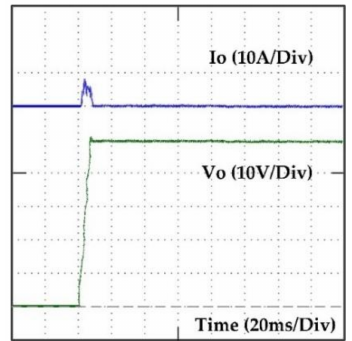
Figure 17. The output current and voltage waveform of the 2.5 kW DAB-IBDC converter during soft-start period at no